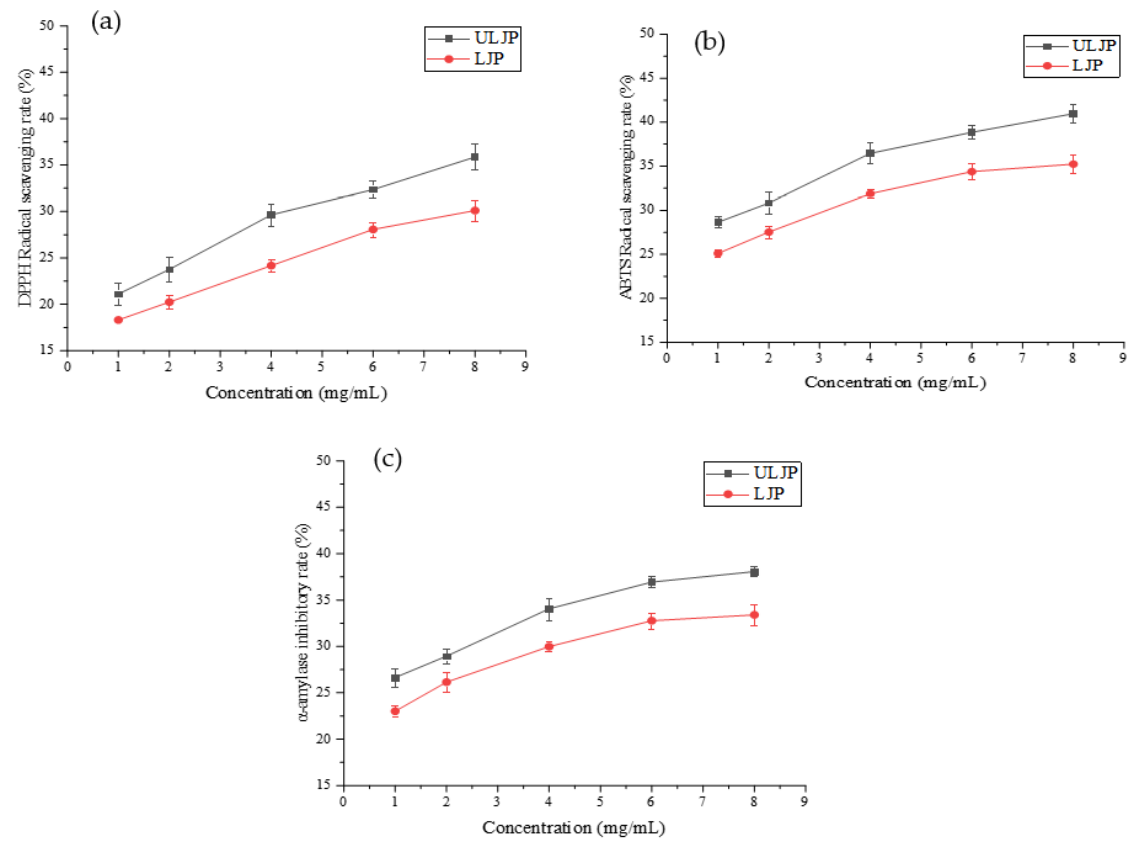
Figure 5. ( a ) Scavenging rate of DPPH free radical by ULJP and LJP. ( b ) Scavenging rate of ABTS free radical by ULJP and LJP. ( c ) Inhibitory rate of α -amylase by ULJP and LJP.